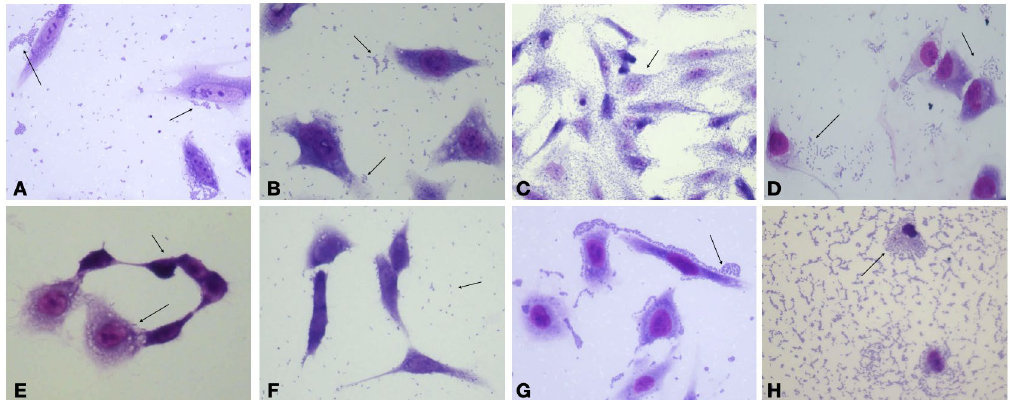
( B ), E. coli 6 M O86:H18 ( C ), E. coli MM O8:H4 ( D ), E. coli MO O25:H4 ( E ), E. coli TM2CRO O9:H28 ( F ), K. pneumoniae BO2 ( G ) and K. pneumoniae JM2CRO ( H ). Arrows point to the adhered bacteria. Magnification 400x.